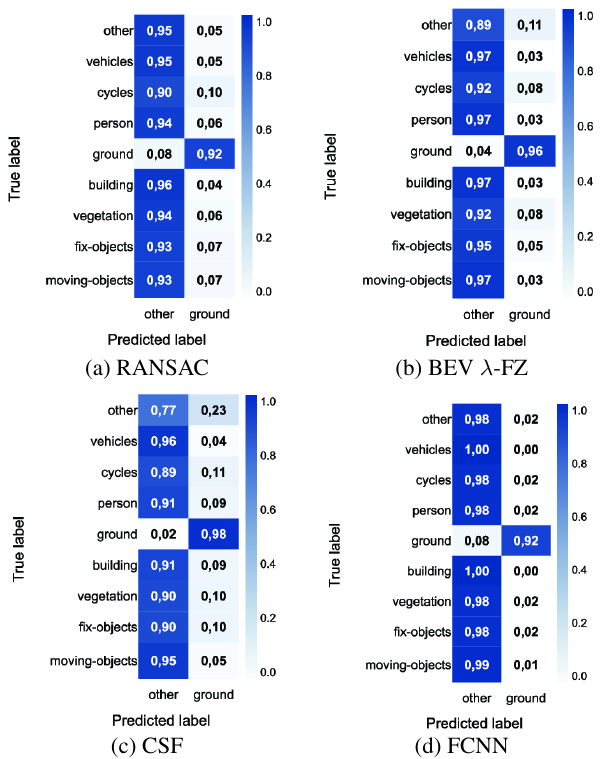
Figure 8. The confusion matrices: (a) Naive RANSAC (b) BEV λ -quasi flat zones (c) CSF (d) FCNN based